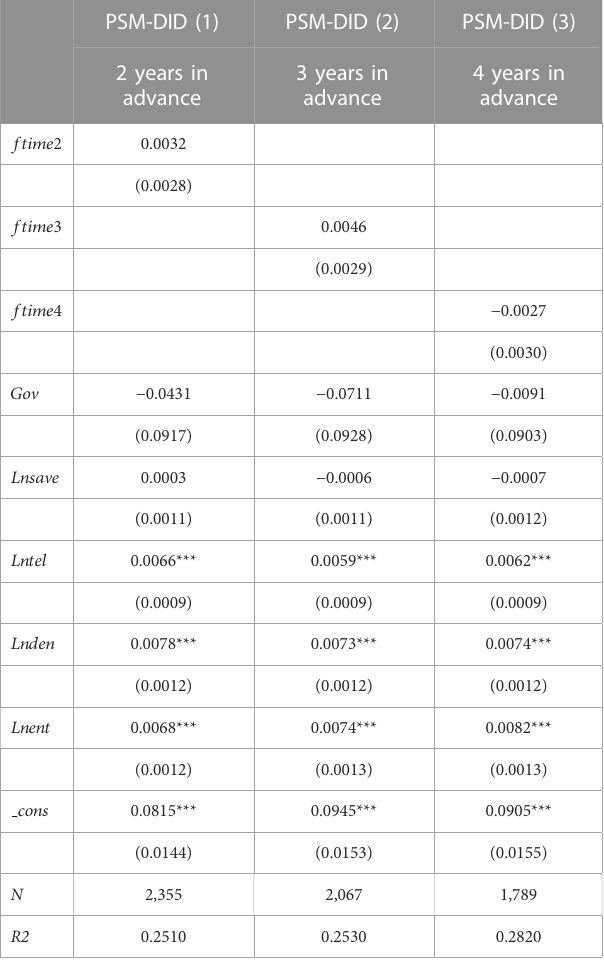
TABLE 9 Placebo test of virtual high-speed rail opening